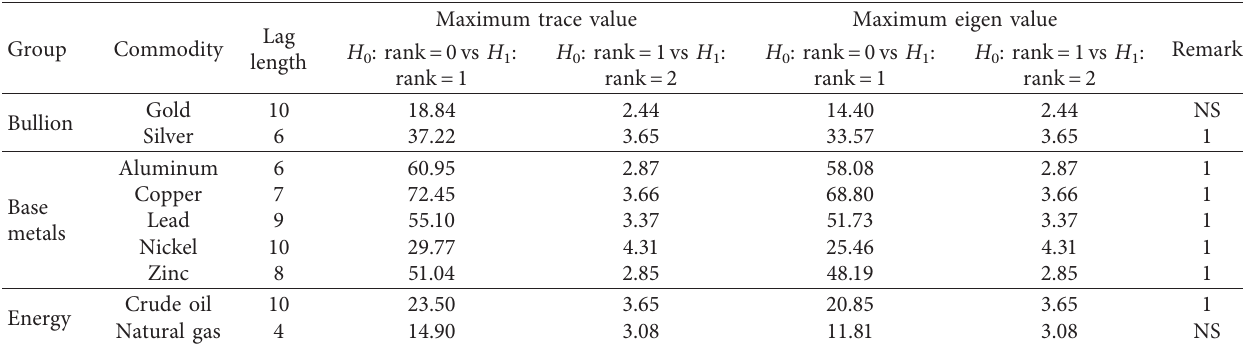
Table 8: Johansen and Juselius cointegration rank test of spot and futures prices. Group